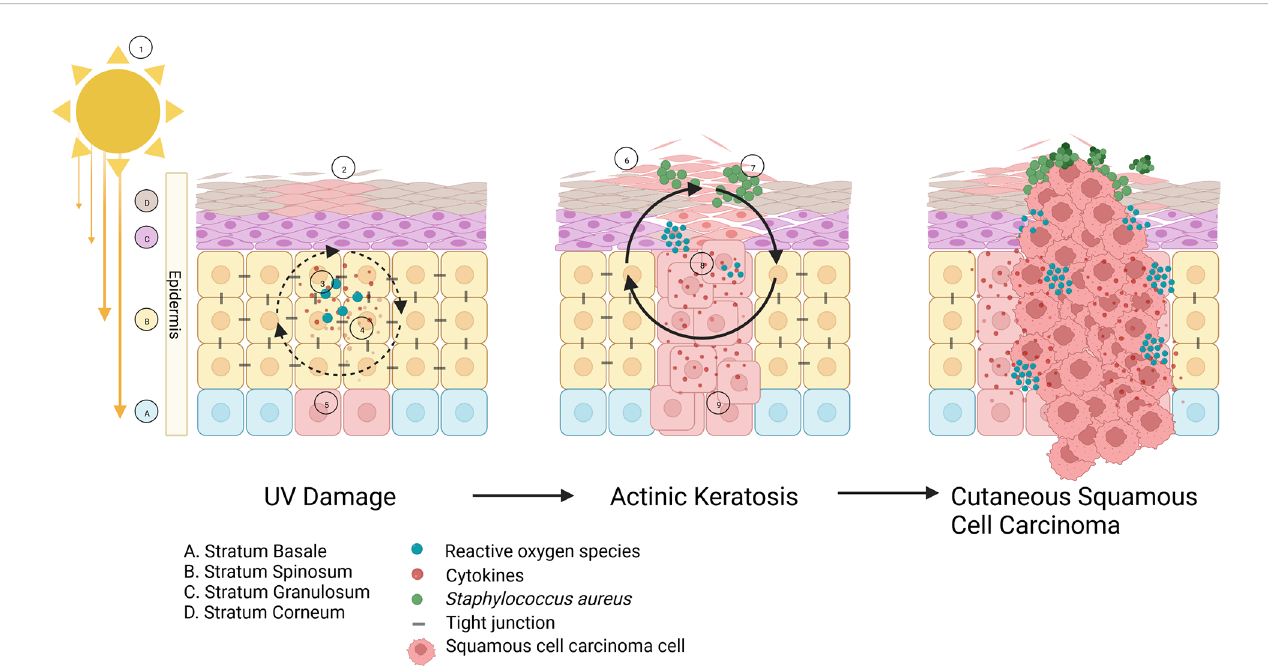
FIGURE 1 The role of bacteria in AK to cSCC progression: ① Sun overexposure causes UV- A/B radiation to penetrate the epidermis, resulting in ② in fl ammatory cytokines accumulating in the area and causing erythema. ③ Reactive oxygen species (ROS) are produced and accrue, leading to oxidative stress. ④ The combination of these factors cause ⑤ DNA damage to keratinocytes and ⑥ skin barrier dysfunction including transepidermal water loss and increased pH. As more UV damage to the keratinocytes occurs, the skin barrier function deteriorates and hyperkeratosis can take place to compensate, forming an actinic keratosis (AK) lesion. Meanwhile, a change in skin physiology results in the healthy skin microbiome becoming dysbiotic, and instead enables pathogenic species such as ⑦ Staphylococcus aureus to proliferate and release toxins which can induce DNA damage and more ⑧ in fl ammation and ROS. ⑨ Squamous cell carcinomas begin developing in the basal layer of the epidermis, and penetrate through the stratum corneum creating a cSCC, that can spread into the basal